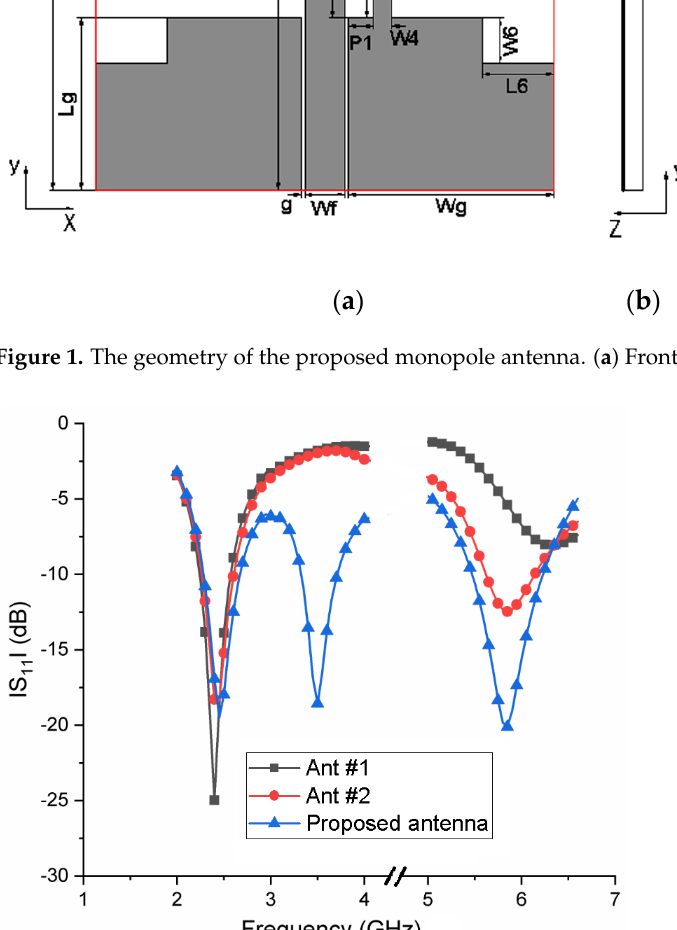
Figure 1. The geometry of the proposed monopole antenna. ( a ) Front view. ( b ) Side view. Table 1. The dimensions of the monopole antenna and EBG unit.